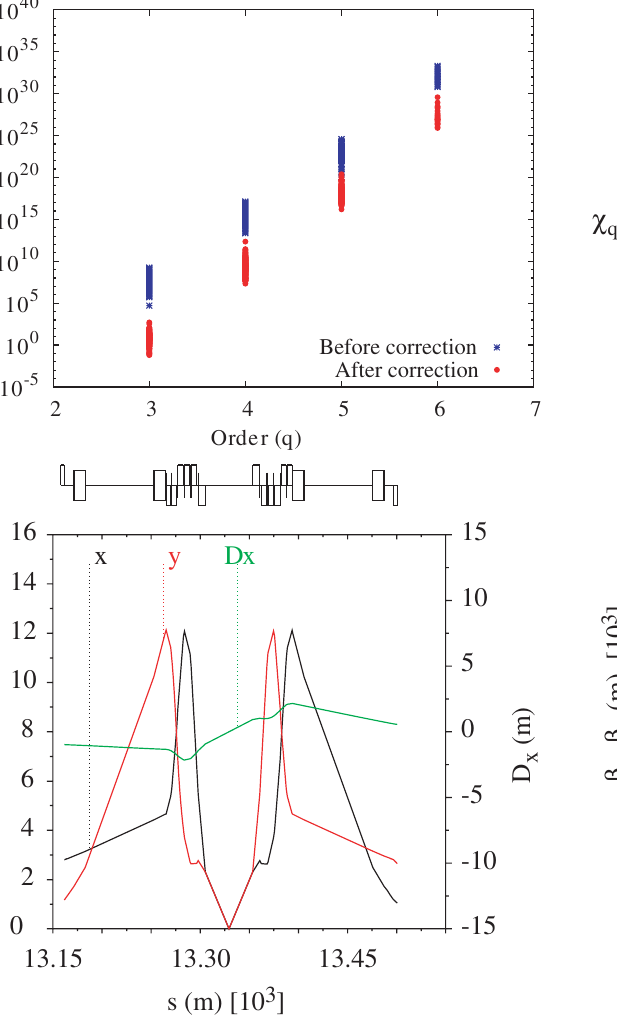
FIG. 1. (Color) Evaluation of the various orders of (cid:2) 2 q (upper plot) before (blue markers) and after (red markers) correction. Sixty realizations of the random magnetic errors are used. The layout is the low- (cid:3) max , whose optical functions are also reported (lower